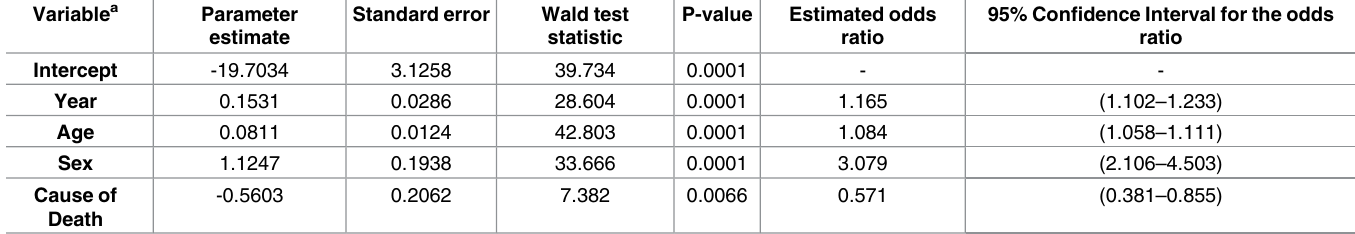
Table 2. Results of multivariable logistic regression analysis to investigate the influence of the explanatory variables year, age, sex, cause of death and sea basin on parasitism of grey seals ( Halichoerus grypus ) with Pseudamphistomum truncatum in the Swedish Baltic Sea 2002–2013. Variable